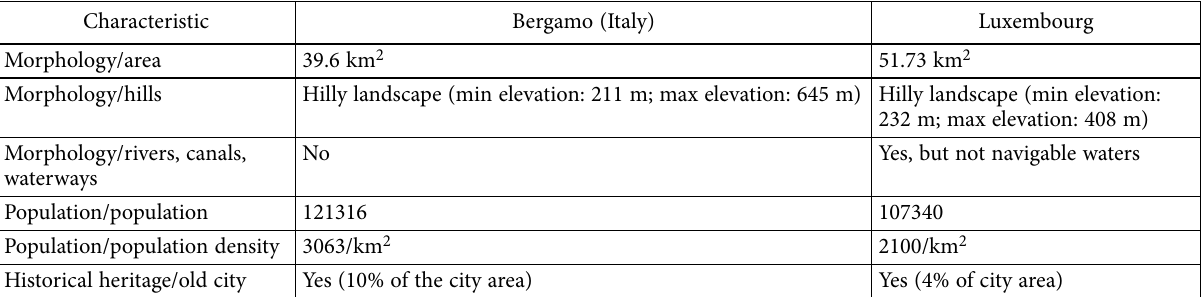
Table 4. Some characteristics of the two case studies (reference year: 2014)